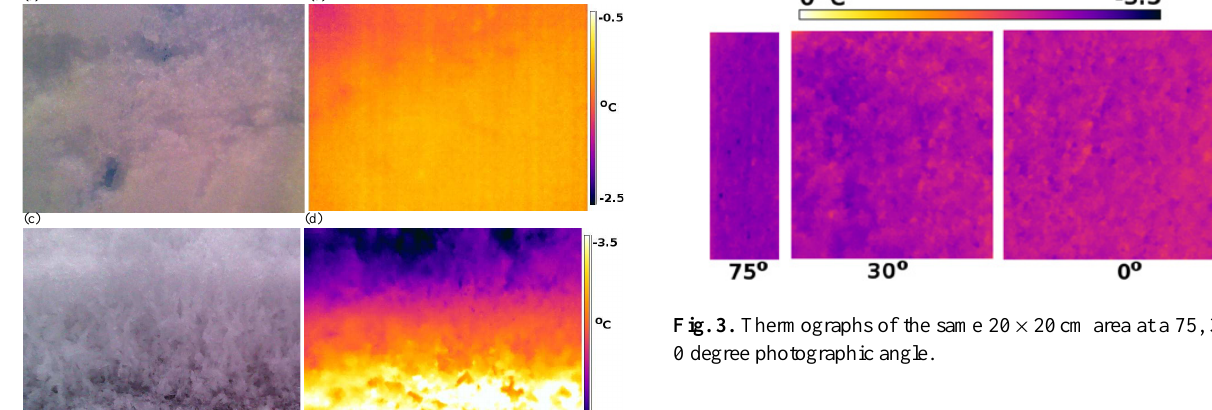
Fig.3. Thermographsofthesame20x20cmareaata75,30,and0degreephotographicangle.